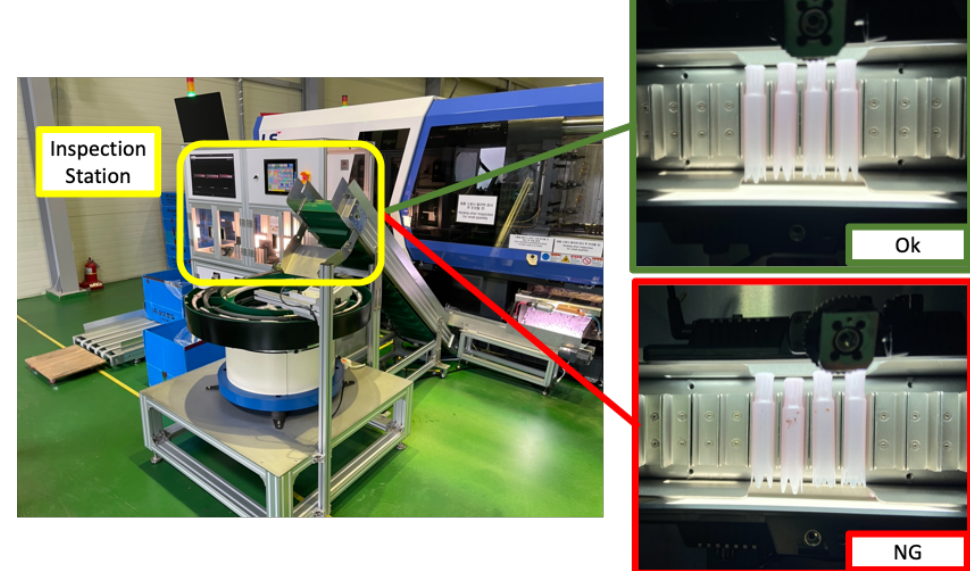
Figure 11. Acquisition of normal and abnormal data by operating the system on